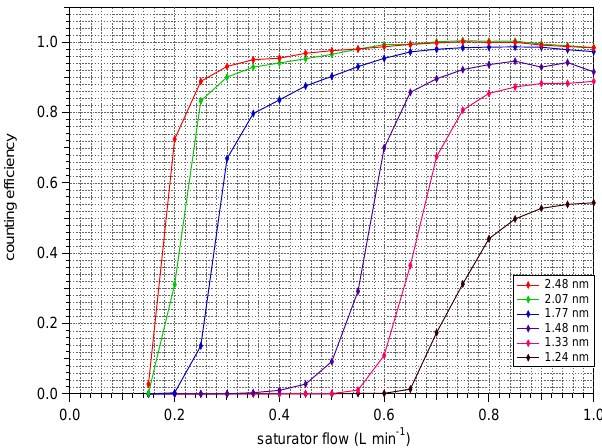
Fig. 2. Detection efficiency of the PSM as a function of the satu- rator flow rate for negatively charged ammonium sulfate particles at different sizes. The different lines are measurements with differ- ently sized particles and determine the saturator flow rate which is needed for achieving the corresponding cut-off